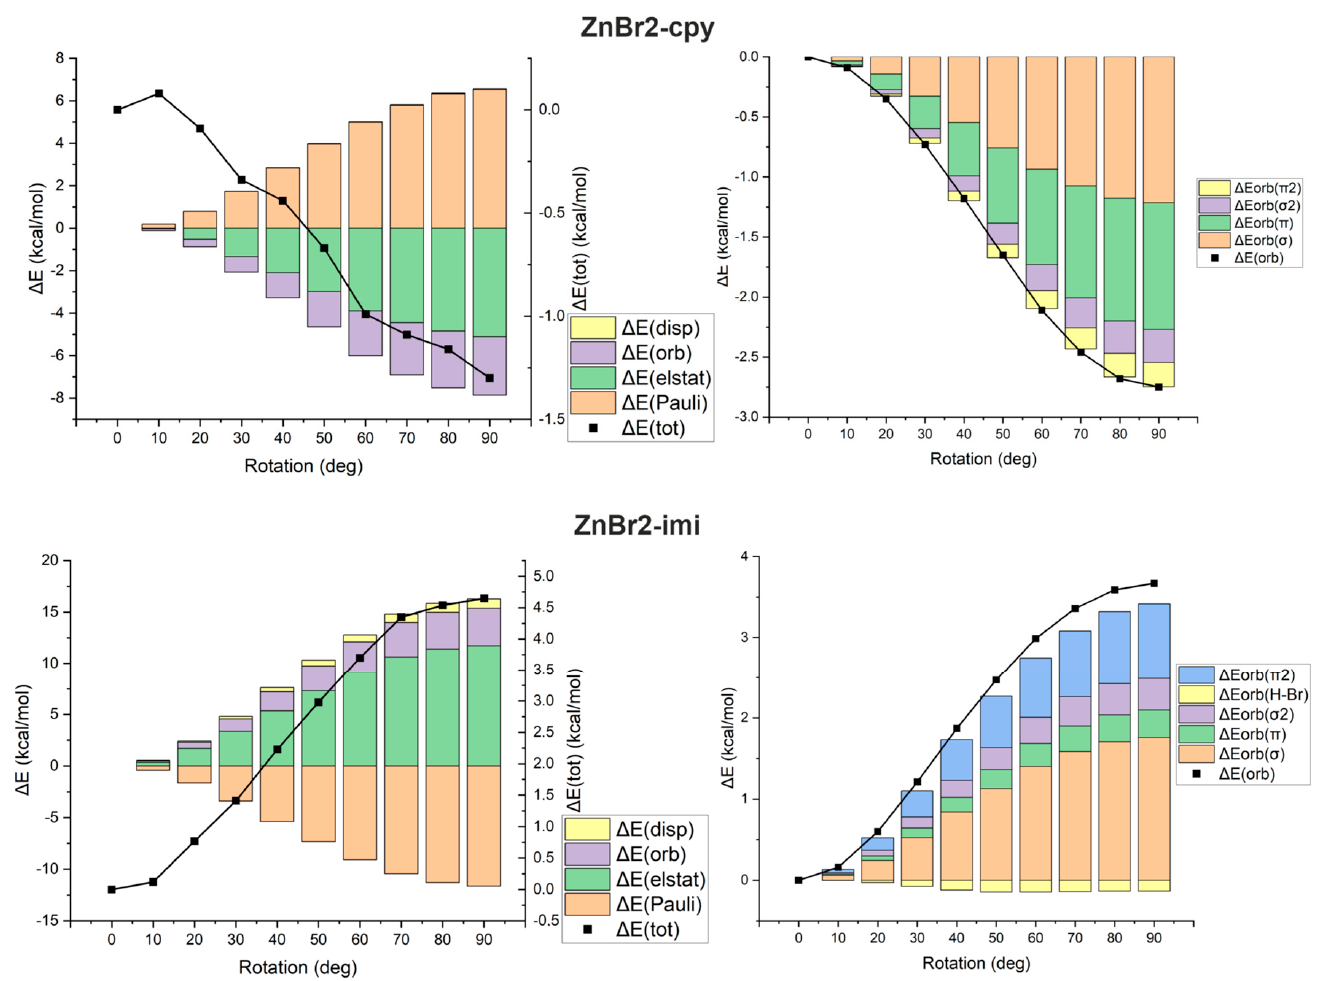
Figure 5. Changes in the values of the ETS-NOCV-based interaction energy components (left) or the orbital energy components (right) with the change of the rotation angle of the ZnBr 2 unit plane with respect to the carbene plane for dimers cyclopropenylidene · · · ZnBr 2 (changes relative to θ = 0 ◦ ; ZnBr 2 -cpy) and imidazol-2-ylidene · · · ZnBr 2 (changes relative to θ = 90 ◦ ; ZnBr 2